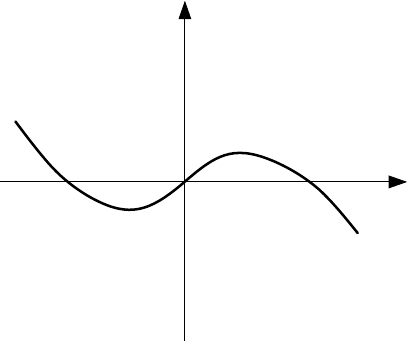
Figure 1. A bistable